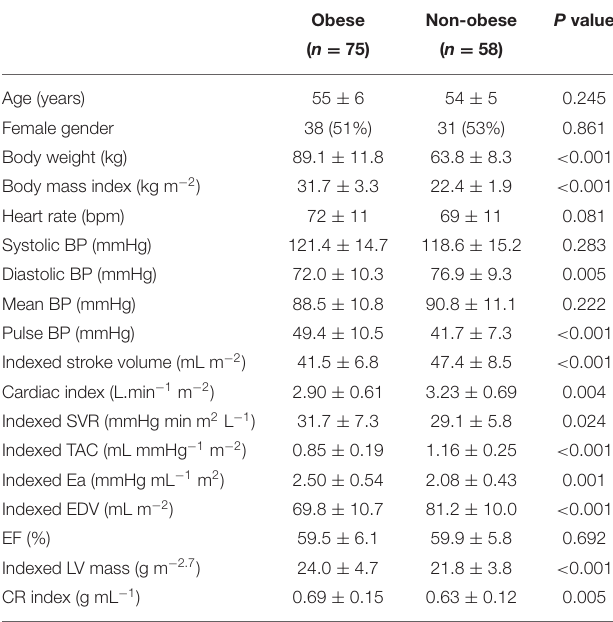
TABLE 1 | Comparison of the main baseline data between obese subjects and non-obese healthy controls. Obese